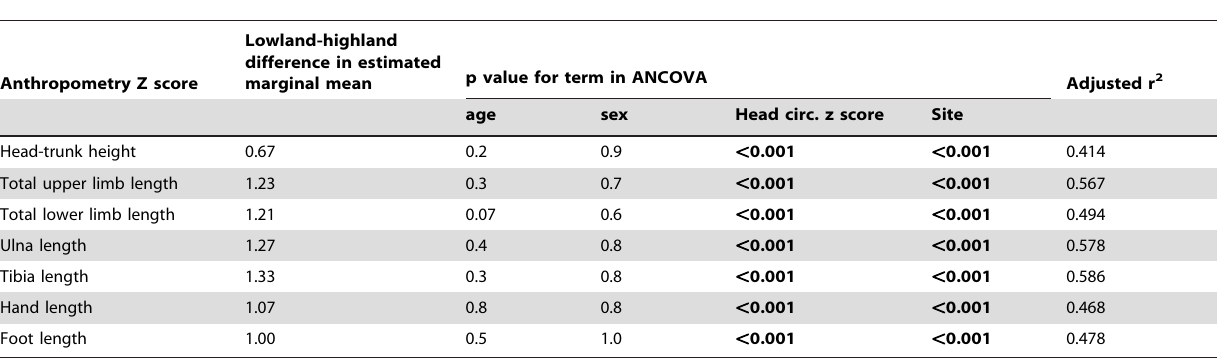
Table 1. Results of ANCOVA analyses for site differences in length z scores, including head circumference z score and age as covariates in the